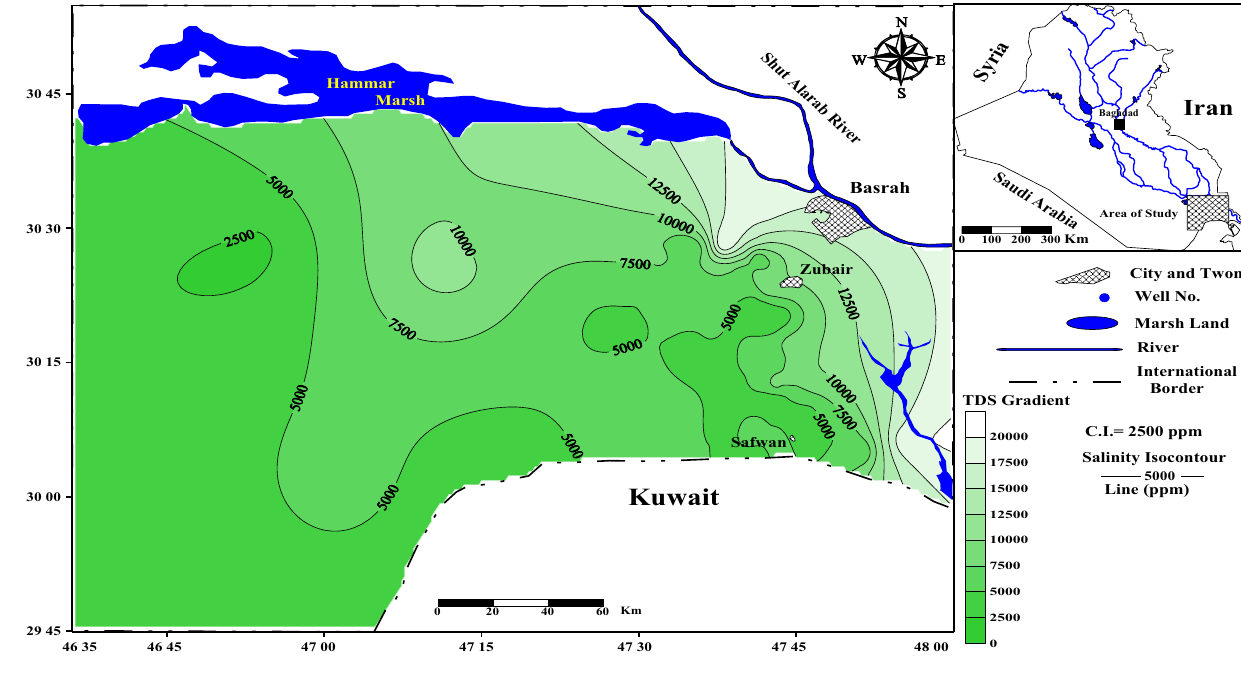
Fig. 8 Groundwater salinity distribution map of the aquifer Fig. 9 Origins and types of groundwater samples in study